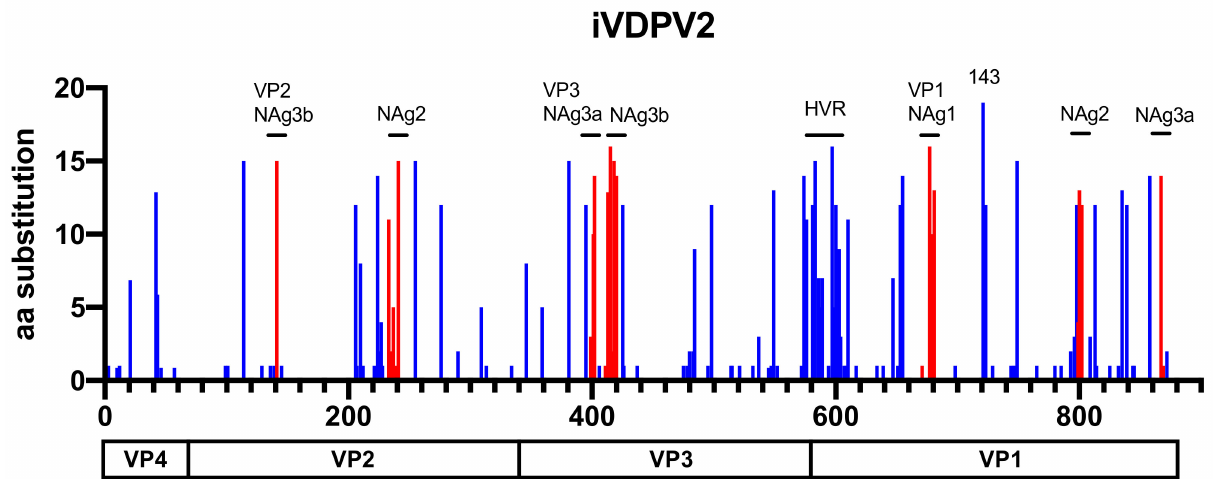
Figure 3. The number of amino acid substitutions in each position of the P1 capsid region of 19 iVDPV2 isolates. The amino acid substitutions in the neutralizing antigenic (NAg) sites are shown in red. The positions of hypervariable residues (HVRs) at the N-terminal and a gatekeeper substitution at VP1–143 of VP1 are